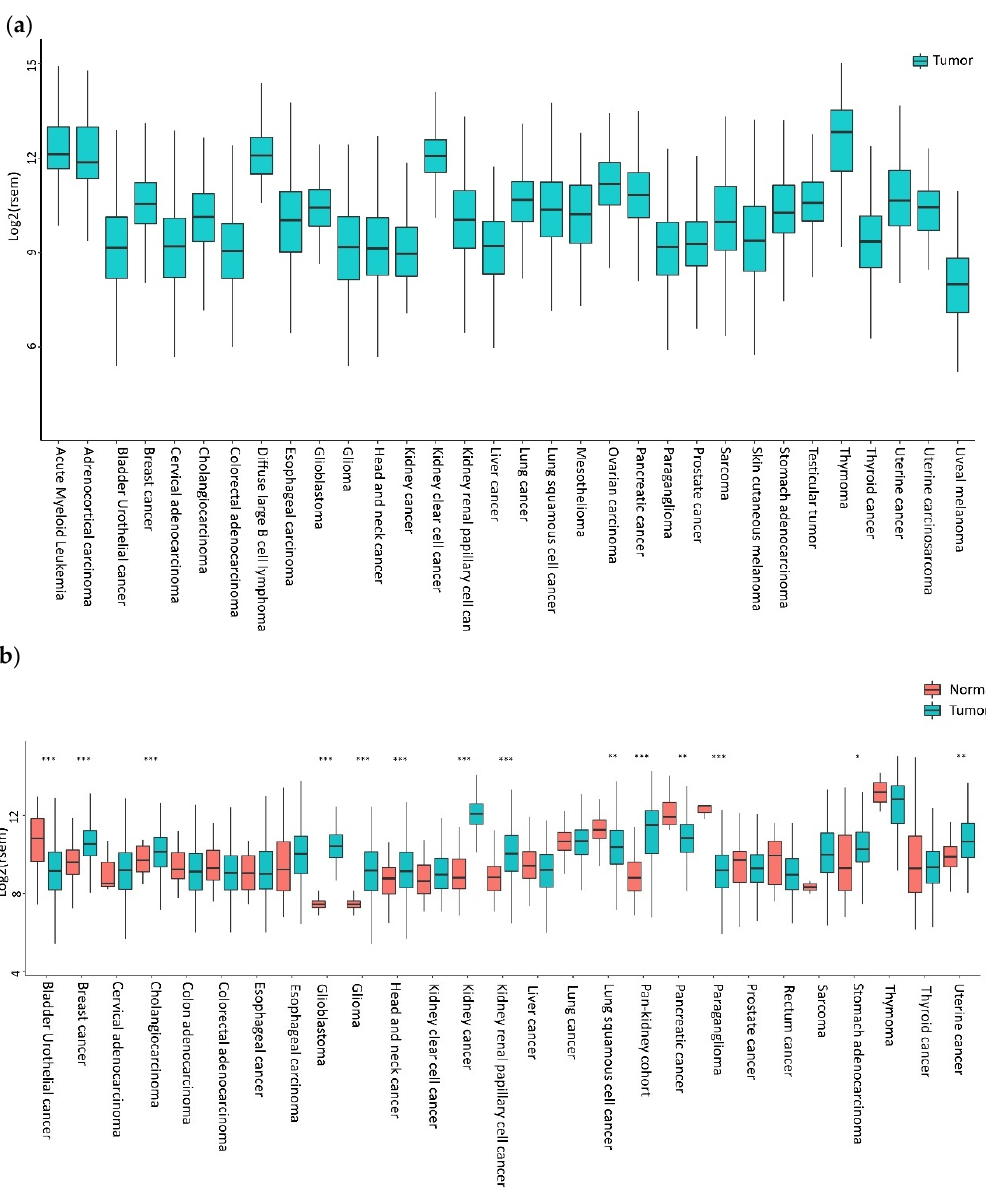
Figure 1. CXCR4 expression in tumors. ( a ) CXCR4 expression in different tumors is investigated by public gene expression data from the Firebrowse repository [72]. Gene expression levels (as normalized RNA-Seq by Expectation Maximization (RSEM) values) were downloaded and distribution boxplots were performed using the ggplot2 R package (version 2_3.2.0) [73] ( b ) Differential expression analysis between normal and tumor samples was performed using the edgeR package (R version 3.5.1; edgeR version 3.24.3) [74,75]. p -values are defined with Fisher’s exact Test.